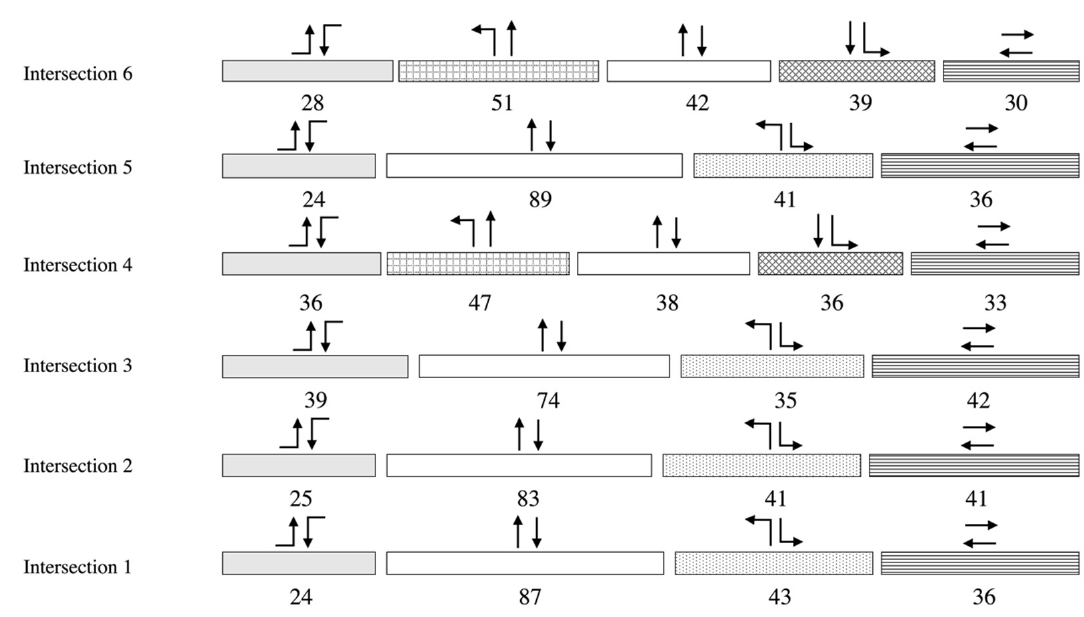
Figure 9. Critical path distribution.